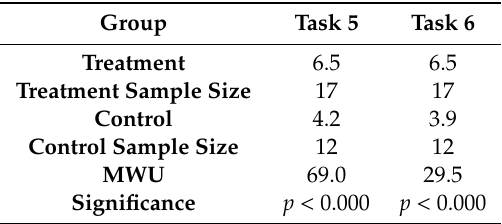
Table 9. Focus tasks